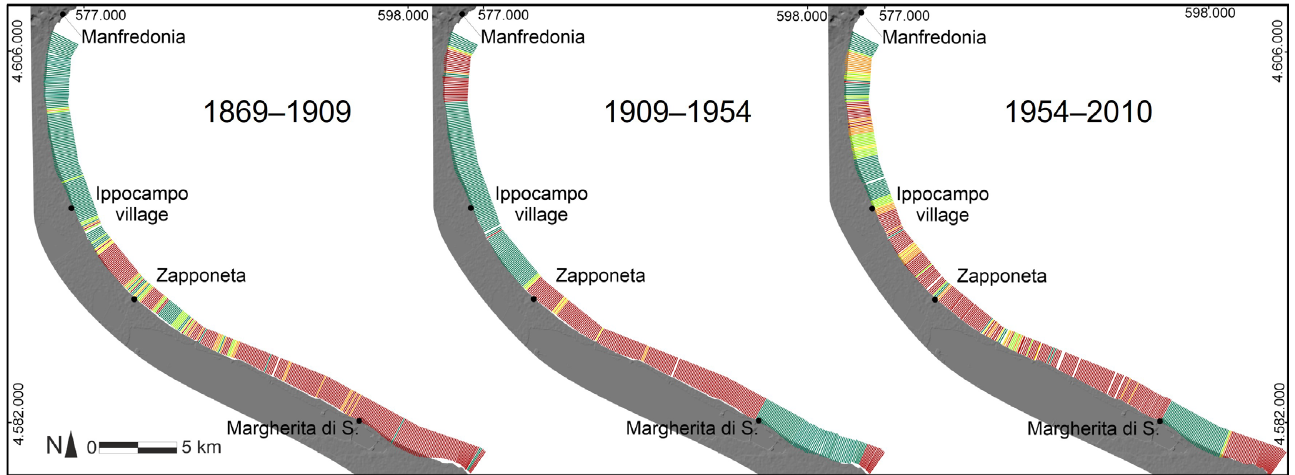
Figure 8. Shoreline trends evaluated for the investigated coastal sector for the period 1869 – 1909 , 1909 – 1954, and 1954 – 2010. The colours refer to the classes proposed in Table 2: light green: low progradation; green: progradation; yellow: equilibrium; orange: low retreat; red: retreat (see Table 2).